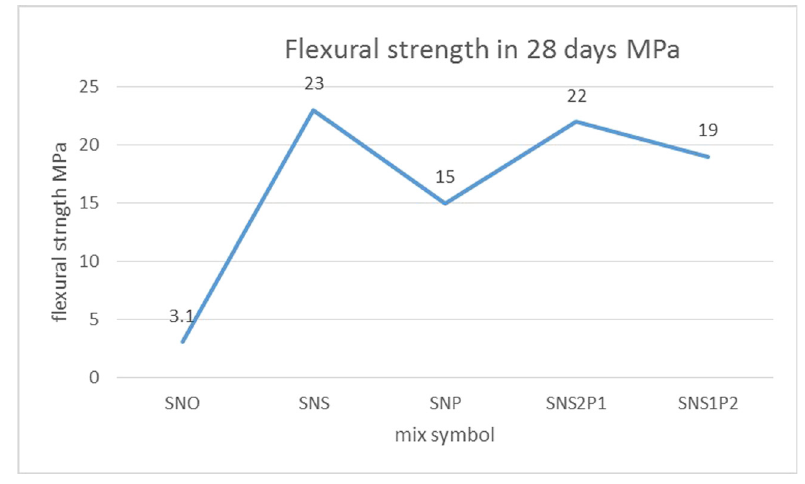
Figure 4: Flexural strength results of SIFCON.